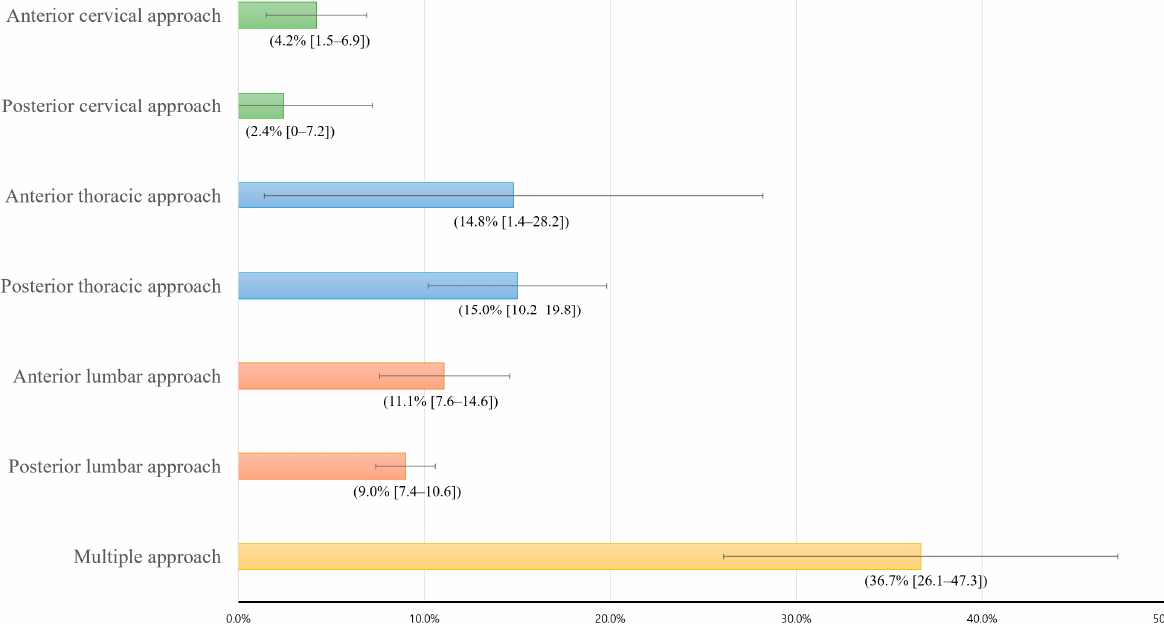
Table 2. Comparison of baseline patient characteristics. Variables